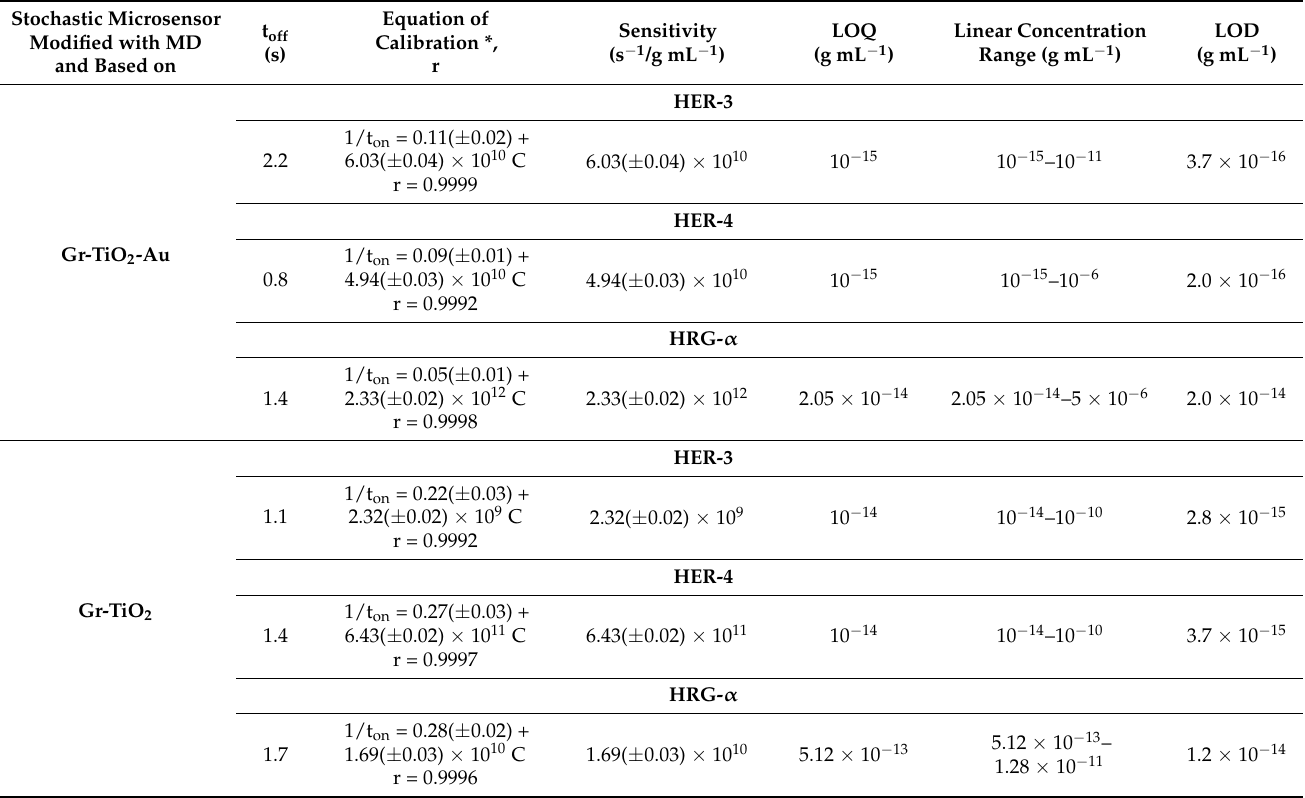
Table 1. The response characteristics of stochastic sensors used for the assay of HER-3, HER-4 and HRG- α